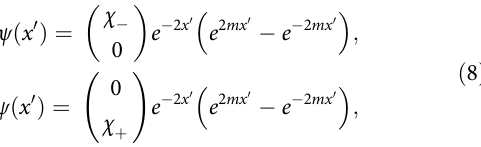
k ¼ k ¼ π = y 0 C